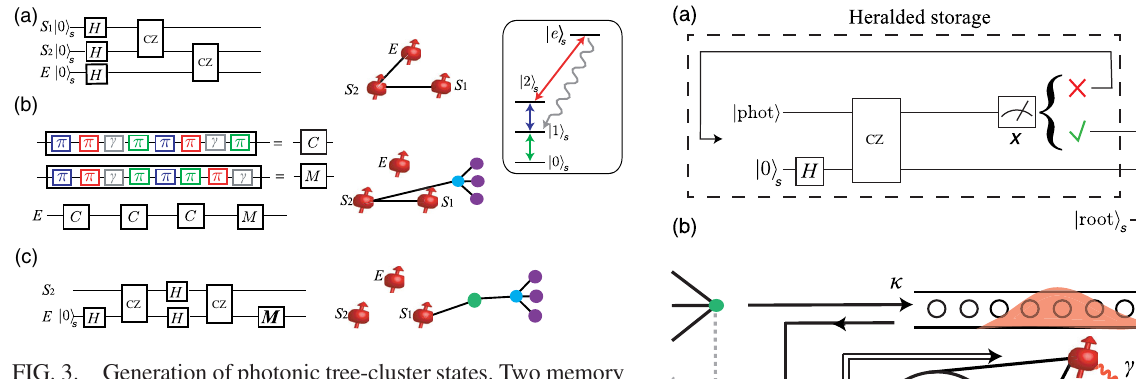
FIG. 3. Generation of photonic tree-cluster states. Two memory spin systems ( S 1 , S 2 ) and a quantum emitter ( E ) are all prepared , and CZ gates entangle the spins as shown in (a). In in state jþi s the second step (b), all third-level photons (purple dots) of one sub-branch of the tree cluster are emitted (operation C ) followed by the emission of the corresponding second-level photon (blue dot), which detaches the emitter from the preliminary tree cluster (operation M ). Operations M and C can be implemented using a sequence of π pulses on various transitions in the emitter, as FIG. 4. The basic elements of the reencoding operation at the indicated by the color code in (b) referring to the color of the repeater stations. (a) The reencoding is performed in a loss transitions in the emitter level diagram shown in the inset. Here tolerant manner by first performing a heralded storage of the driven transitions are indicated by solid lines, whereas decay ( γ ) message qubit in an auxiliary memory spin (dashed box). This is is represented by the wiggle line. To emit more second-level obtained through a spin-photon controlled-phase ( CZ ) gate with a followed by a CZ gate with S 2 qubits, E is again prepared in jþi s first-level photon of the encoded tree. The transfer is heralded by and step (b) is repeated. In step (c), the state of the memory spin is the detection of the photon in the x basis. If unsuccessful (photon first swapped to the emitter and then emitted as the first-level loss), the auxiliary spin is initialized and the operation is tried photon of the branch. Here the emission of the first-level photon again with another first-level photon. Once the storage is is achieved by an operation M , which is similar to M except that successful, a deterministic Bell measurement is performed the red π pulse and subsequent decay is replaced by a weak between the auxiliary spin and the root spin qubit of the new − j e i transition to ensure that the photons driving of the j 2 i s s tree cluster, thereby completing the reencoding operation. (b) The have a narrow bandwidth. The steps are then repeated until the experimental implementation of the reencoding operation. The entire tree has been emitted. spin-photon CZ gate is performed by reflecting the photonic qubit off a one-sided cavity (shown as a photonic crystal cavity) strongly coupled to a quantum emitter, as described in the text. The parameters g , γ , and κ are the single-photon Rabi frequency of the optical transition, the spontaneous emission rate of the emitter, and the decay rate of the cavity field, respectively. The same physical setup is used to generate the tree-cluster state requiring an extra spin qubit and one auxiliary level ( j 2 i quantum emitter (see Fig.